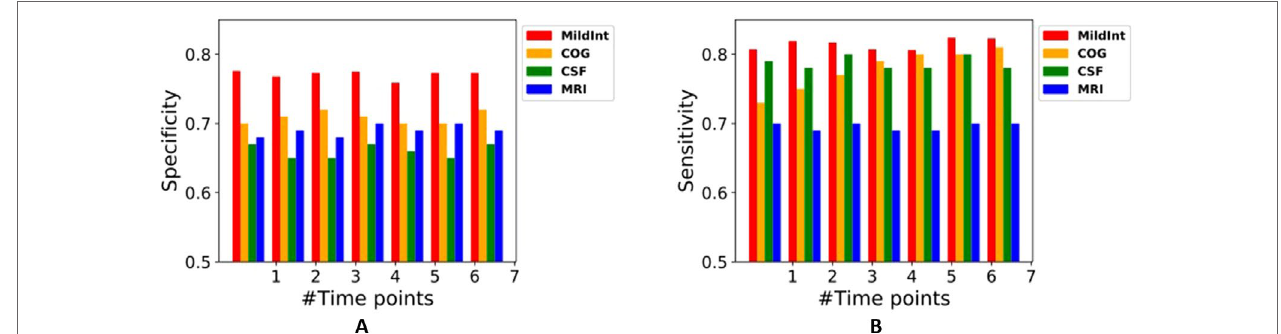
FIGURE 4 | Predictive performances using multi-modality and single modality of data.